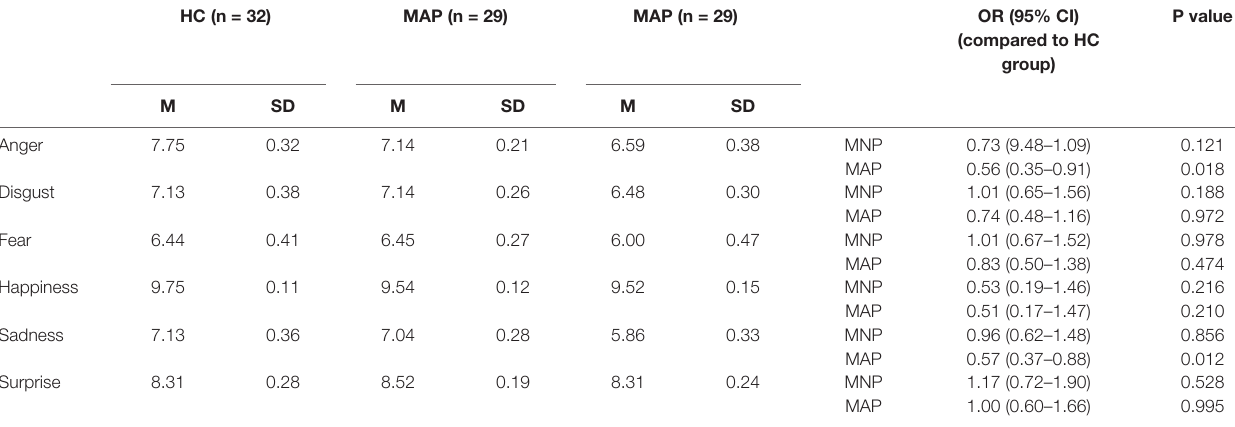
TaBlE 3 | Discrete emotion recognition across